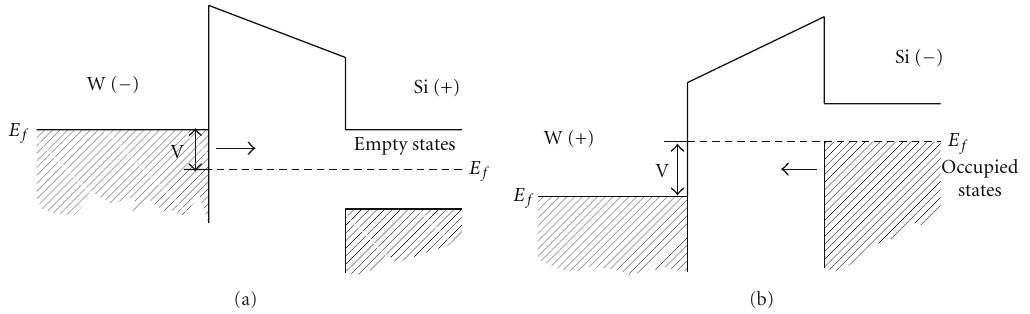
Figure 4: Schematic representation of asymmetric tunneling due to the material asymmetry of a junction such as tungsten/silicon (W/Si); (a) corresponds to forward bias +V; (b) corresponds to reverse bias − V [12].